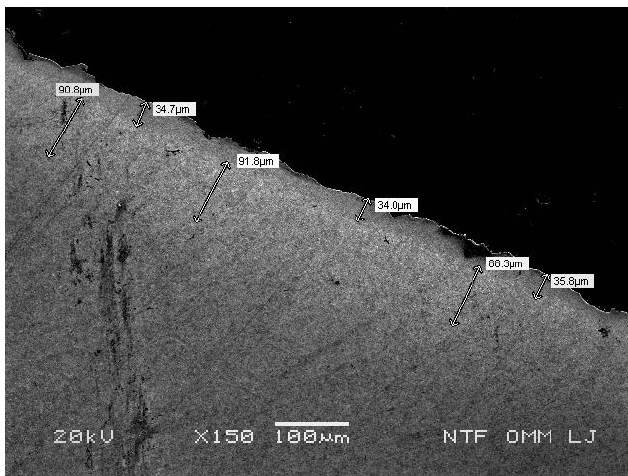
Figure 17. A view at the working surface that was in contact with the rock.